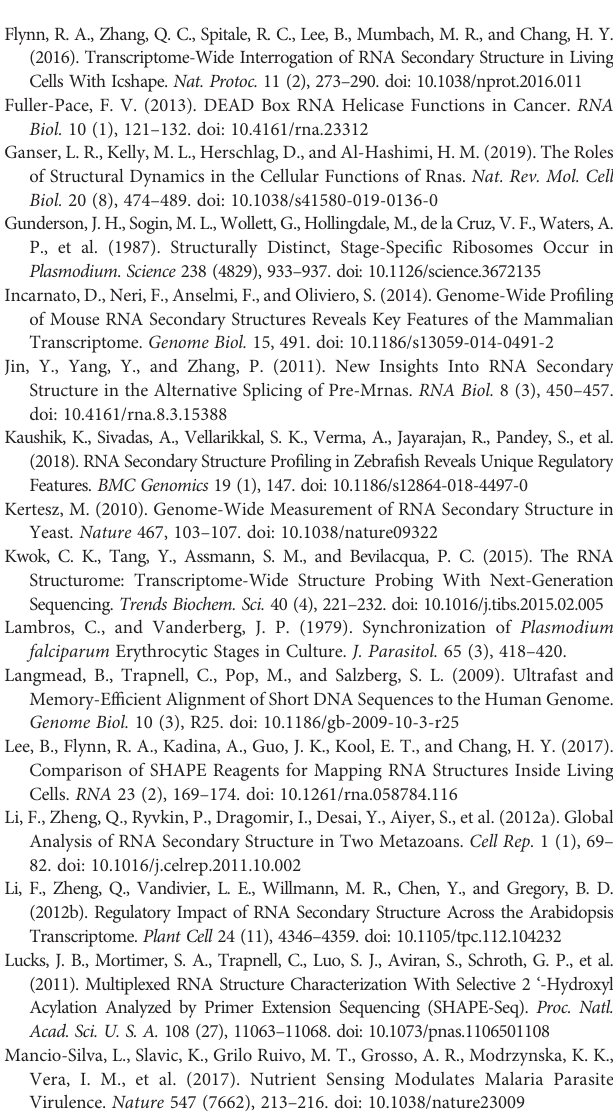
Supplementary Figure 3 | Secondary structure of Plasmodium falciparum 18S small subunit ribosomal RNA (blood stage) in vivo NAI-N 3 modi fi cation identi fi ed by icSHAPE. Supplementary Figure 4 | Overview of the icSHAPE approach in our experiment Overview of the icSHAPE approach used for temperature-responsive in vivo and in vitro RNA structurome of Plasmodium falciparum in our experiment. P. falciparum was cultured in human O+ erythrocytes at 5% hematocrit at 37°C. Cultures were synchronized twice at ring stage with 5% D-sorbitol treatments performed 8 hours apart. We performed to culture parasites at 48/72 (ring stage/trophozoite stage) hours after the fi rst synchronization experiment. Then parasites were lysis by 1% saponin, following by RNA structure modi fi cation by NAI-N 3 or extract total RNA from parasite directly. During NAI-N 3 modi fi cation, we set a DMSO-treated negative control sample for that the DMSO sample can provides an ‘ input ’ sample. In vitro RNA structure experiments were done by treating the total RNA from DMSO- treated sample with NAI-N 3 . After library preparation and Illumina sequencing, the count of mapping reads from sequencing generated NAI-N 3 in vitro , NAI-N 3 in vivo , and DMSO-treated control pro fi les. Finally, visualization the RNA secondary structure at difference stages and fi nd the relationship between RNA secondary structure and gene